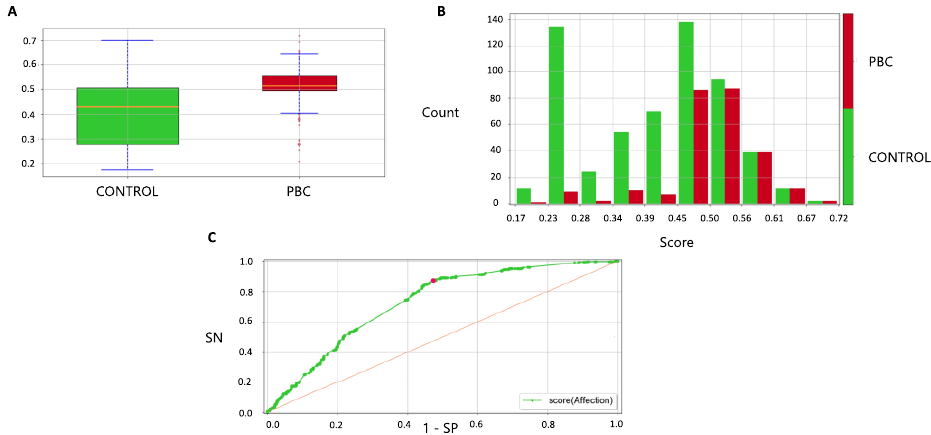
Figure 5. Model performance in the validation cohort. ( A ) Score distribution between cases and controls in the validation cohort. In the box plot, boxes define the interquartile range; thick lines refer to the median. The p -value was calculated using the Wilcoxon rank sum test. Legend: 1 = healthy control (green color), 2 = PBC case (red color). ( B ) Proportion of cases and controls by deciles of score in the validation cohort. Legend: 1 = healthy control (green color), 2 = case (red color). ( C ) ROC curve for case-control discrimination in the validation cohort. AUC, Area Under the Curve; PBC, Primary Biliary Cholangitis; ROC, Receiver Operating Characteristics.